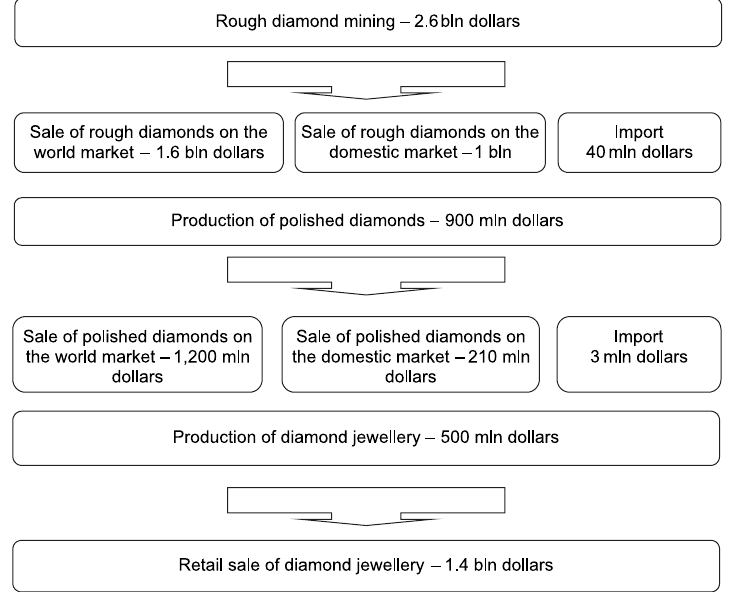
Fig. 2. The diamond pipeline in Russia in 2008 (on the basis of Pototskaya